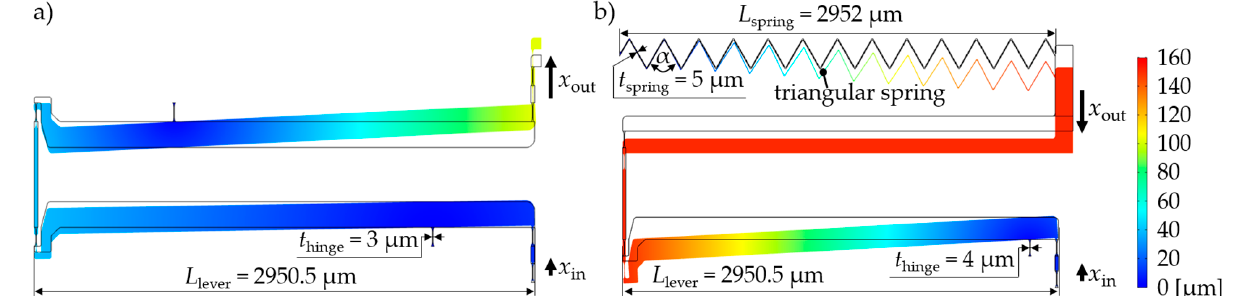
Figure 6. MechAMPs displaced the distance x in = 10 µm by the COMSOL Multiphysics simulation. Due to the symmetric setup, only the left hand side of the mechAMPs is shown. ( a ) MechAMP+ amplifies the input displacement x in in a large output displacement x out , and ( b ) MechAMP– amplifies and inverts the input displacement x in in a large and inverse output displacement x out .